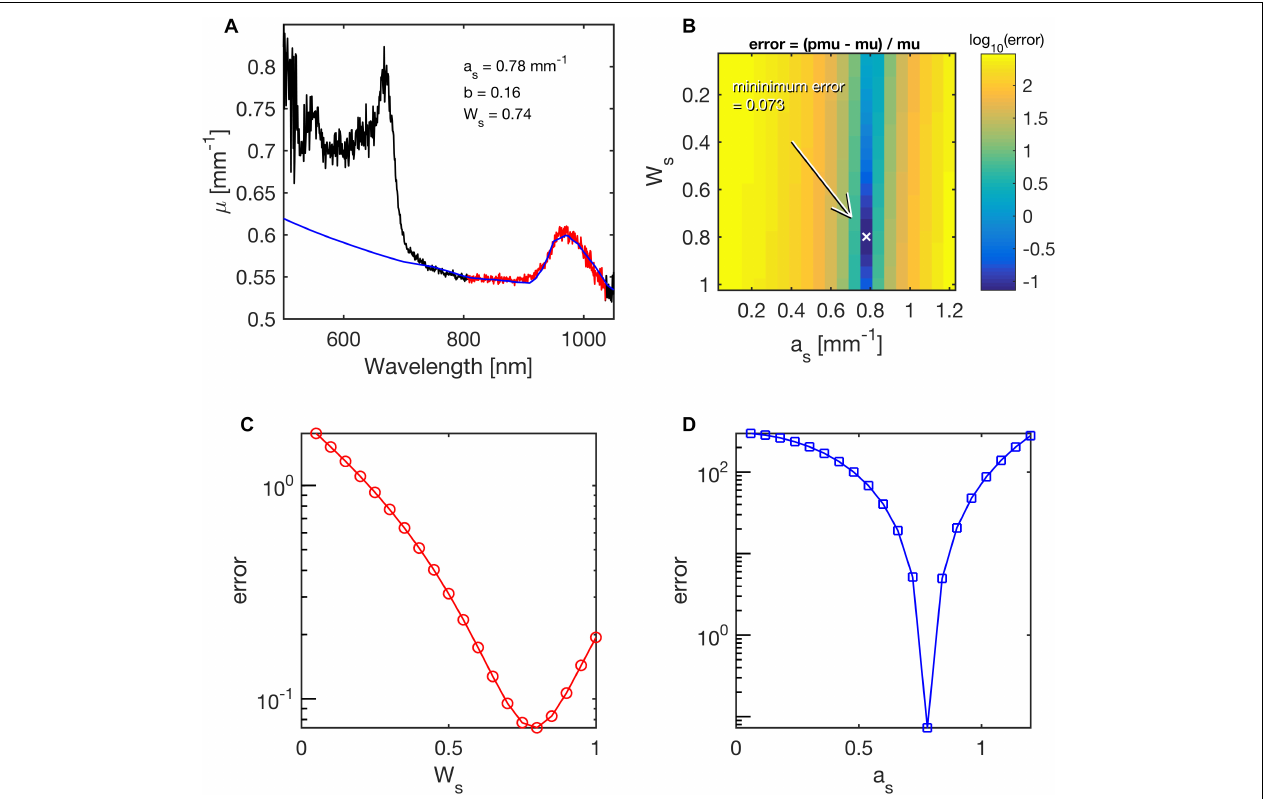
FIGURE 3 | Example of fitting coral skeletal scattering (a s ) and water content (W s ) during least-squares fitting of the lateral attenuation coefficient µ ( λ ) for 750 nm < l < 1030 nm in Acropora millepora. The mapping of errors for a s and W s , yielded best values of 0.78 mm − 1 and 0.74 mm − 1 , respectively. (A) The fit (blue line) to the spectral range in red. (B) Map of the error for various choices of a s and W s . The parameter b was held at its fitted value of 0.16. Arrow points to minimum error. (C) Error in W s , while a s was held at its best value. (D) Error in a s , while W s was held at its best